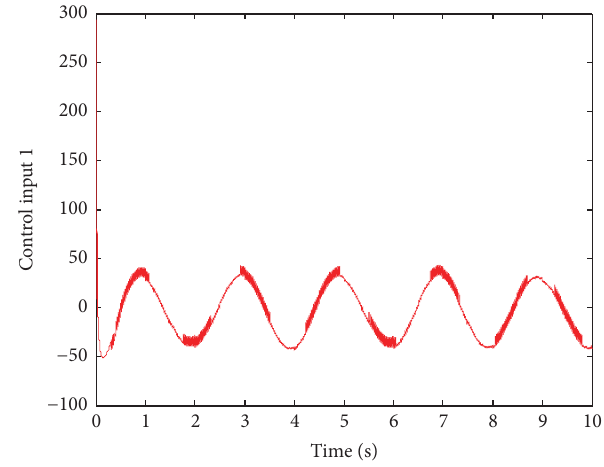
Figure 19: Control input signal 𝑢 1